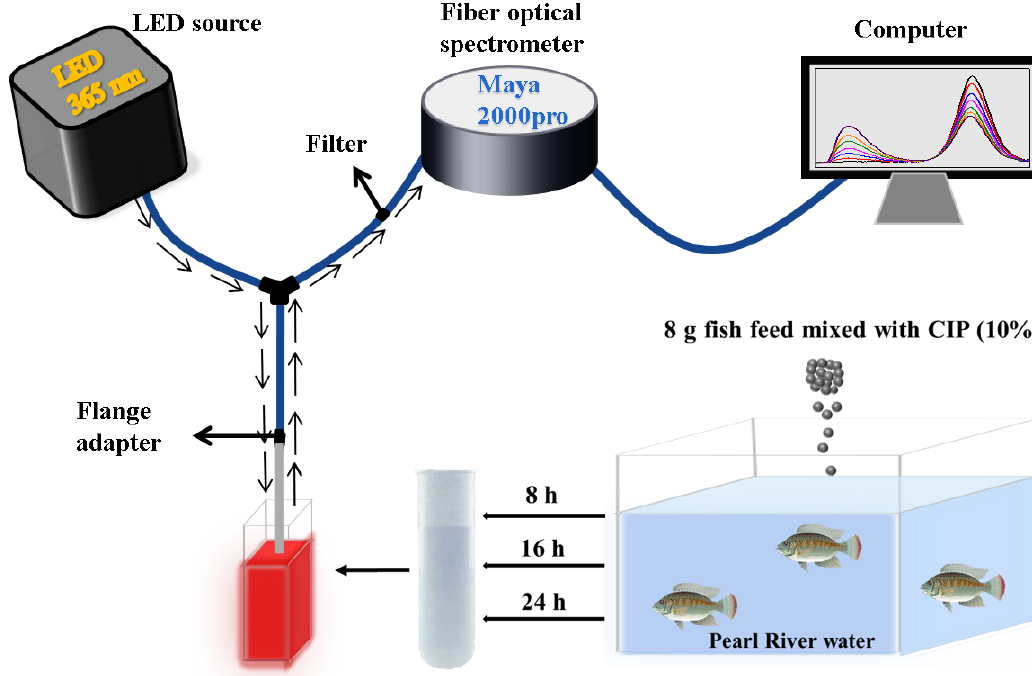
Figure 1. Scheme of optical fiber spectrum detection system.